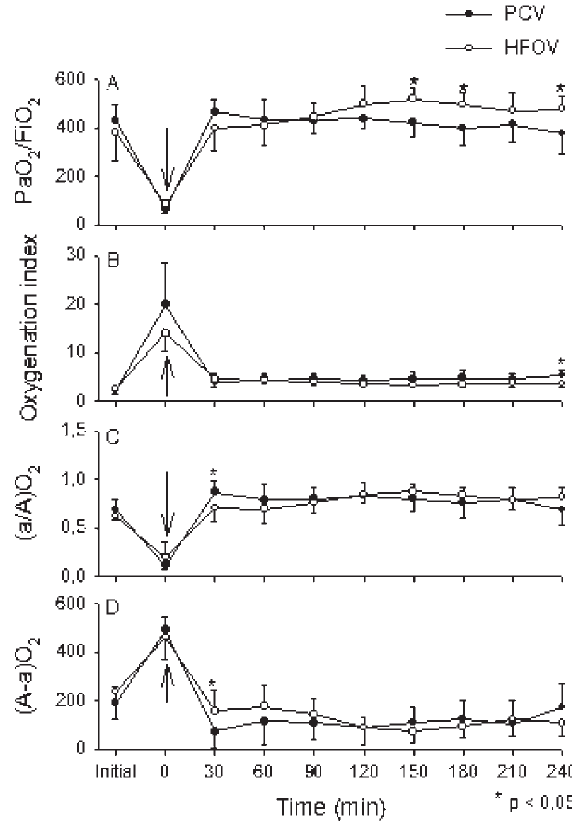
Figure 2 - Group mean±SD are shown for PCV group (closed circles) and HFOV group (open circles). “Initial” time are values before lung lavage; “zero” time corresponds to values immediately after the installation of the experimental model. The arrow indicates the moment of LIP determination /FiO . The HFOV and beginning of both ventilatory strategies. Panel A : PaO 2 2 group presented better oxygenation at 150, 180 and 240 min; Panel B : Oxy- genation index; Panel C : (a/A)O and Panel D (A-a)O . Similar increase in 2 2 oxygenation with the beginning of ventilatory strategies was seen in both groups, with small but significant difference favoring the HFOV group at 240 min ( Panel B ) and 30 min ( Panel C and Panel D )